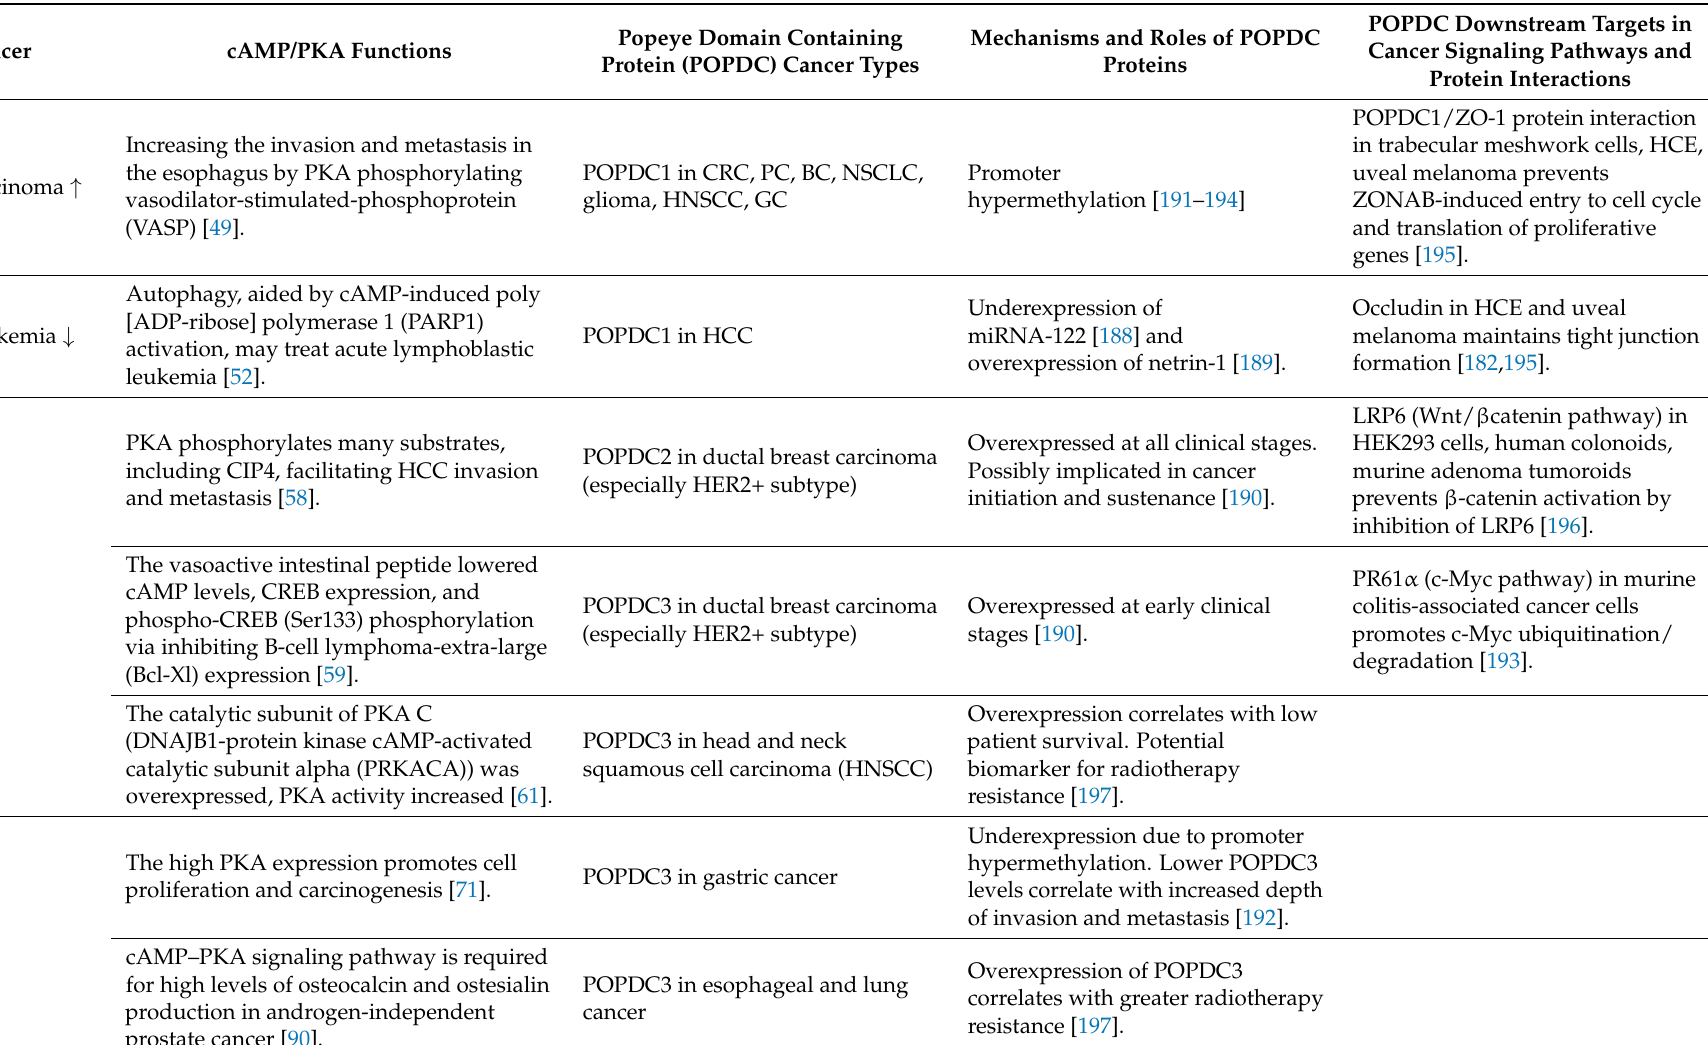
Table 1. cAMP/PKA functions and POPDC proteins’ roles, downstream targets, and downregulations associated with various cancer